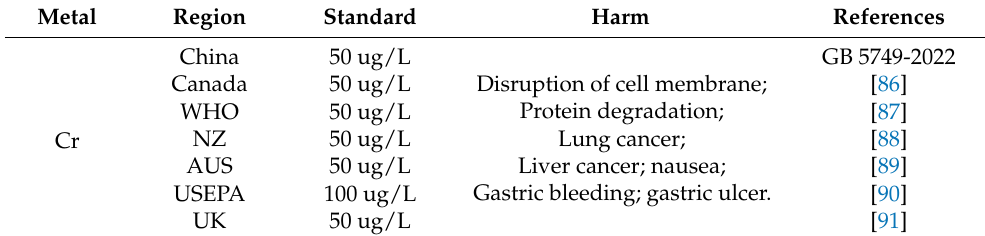
Table 4. Control Standard of Cr in Different Areas and Harm of Cr.